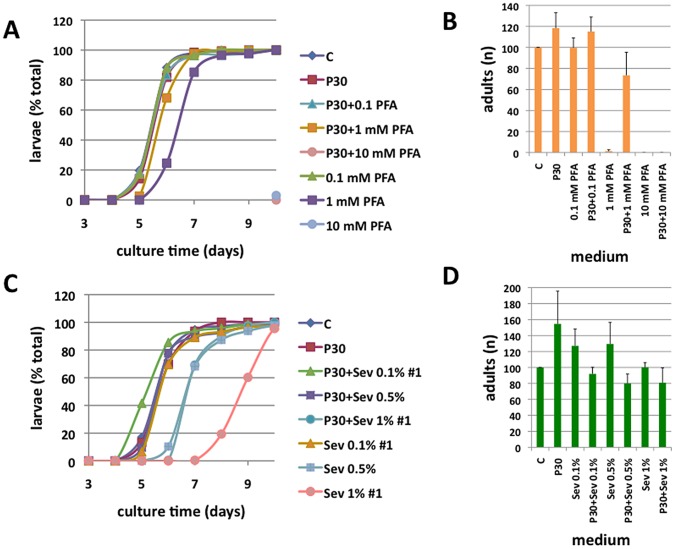
The effect of sevelamer and PFA on larval development is reversible by addition of 30 mM phosphate to the medium.
A, C: Number of larvae emerged from the medium. P30 = standard medium supplemented with 30 mM sodium phosphate (pH 6.0), PFA = phosphonoformic acid 0.1–10 mM, Sev = sevelamer 0.1–1%; Shown are means, CV<10%, B, D: Number of adults eclosed. Shown are means ± SEM of one representative experiment, performed in triplicate.